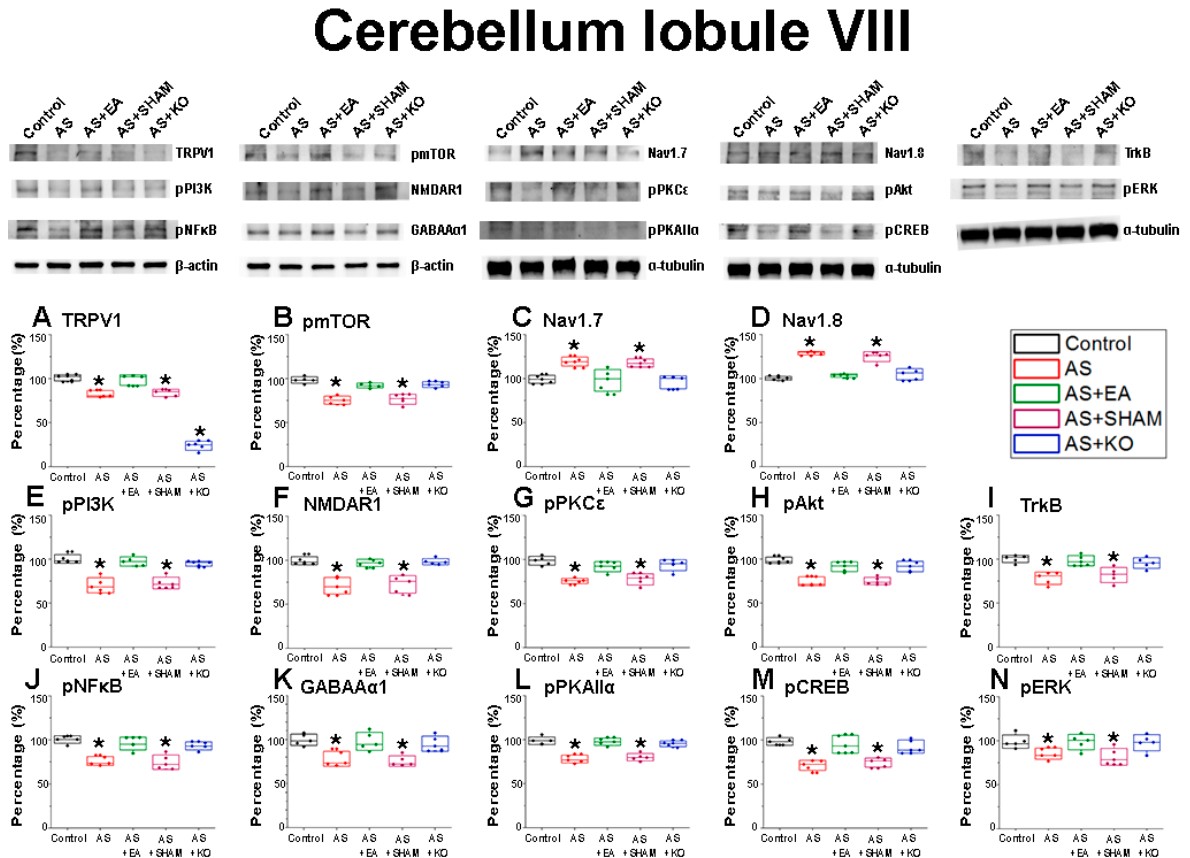
Figure 4. The expression levels of nociceptive receptors and associated molecules in the cerebellum lobule VIII. The immunoblotting images depict five lanes of protein in the following order: Control, AS, AS + EA, AS + SHAM, and AS + KO groups. There are significant decreases in protein expression in the AS and AS + SHAM groups of ( A ) TRPV1, ( B ) pmTOR, ( E ) pPI3K, ( F ) NMDAR1, ( G ) pPKC ε , ( H ) pAkt, ( I ) TrkB, ( J ) pNF κ B, ( K ) GABAA α 1, ( L ) pPKAII α , ( M ) pCREB, and ( N ) pERK levels, which were significantly augmented in the AS + EA and AS + KO groups. Both the AS + EA and AS + KO groups displayed no difference when compared to the Control group, depicting an observable improvement of CPDC tendencies. However, the protein expression levels of ( C ) Nav1.7 and ( D ) Nav1.8 displayed states of significant increases in the AS and AS + SHAM groups when compared to the Control group. Furthermore, this increase was significantly ameliorated in the AS + EA and AS + KO groups, which retained states of non-significance when similarly compared to the Control group. Accordingly, the protein density of the AS + KO group revealed a predicted decrease in ( A ) TRPV1 (* p < 0.05).